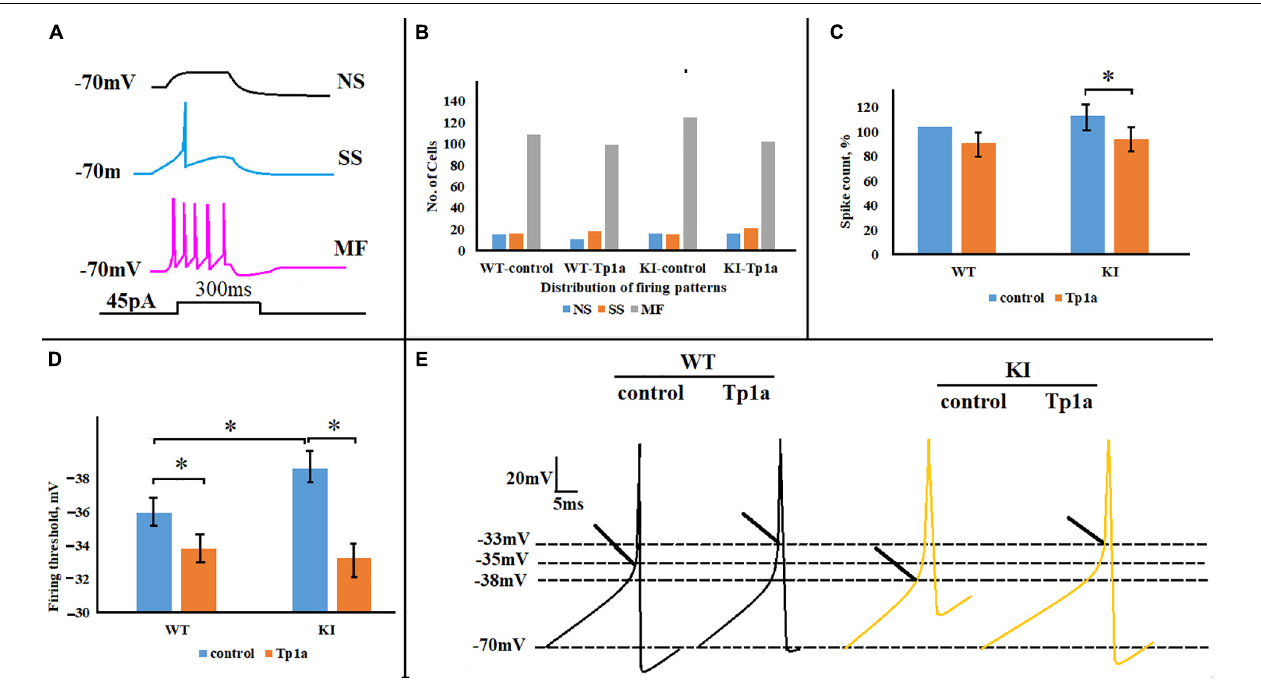
FIGURE 5 | Effects of Tp1a on firing of TG neurons evoked by a 45-pA 300-ms square current pulse. (A) Cell-specific firing patterns recorded from three different WT TG neurons in response to the same stimulation. NS, no-spiking cell; SS, single-spike cell; MF, multiple-firing cell. (B) Distribution of firing patterns in WT and R192Q KI TG cultures is very similar in control and after application of Tp1a (7 nM, 30 min); chi-square test for proportions. Number of cells in each group for NS, SS, and MF cells, respectively: n (WT, control) = 15, 16, 109; n (WT, Tp1a) = 11, 18, 99; n (KI, control) = 16, 15, 125; n (KI, Tp1a) = 16, 21, 102. (C) Histograms represent the percent change of the number of spikes, generated by WT and KI neurons in control and after 30 min application of 7 nM Tp1a. *Indicates statistically significant change (Mann–Whitney test, p -values are given in the text body). Number of cells in each group: n (WT, control) = 109, n (WT, Tp1a) = 99, n (KI, control) = 133, n (KI, Tp1a) = 102. (D) Averaged firing threshold of WT and KI neurons in control and after Tp1a (7 nM, 30 min). *Indicates statistically significant change (two-sample Student’s t -test, p -values are given in the text body). Number of cells is as in (C) . Note more negative KI threshold value in control and depolarized WT and KI thresholds after Tp1a application. (E) Representative traces of the first generated AP by WT and KI control and Tp1a-treated (7 nM, 30 min) neurons. Arrows indicate AP